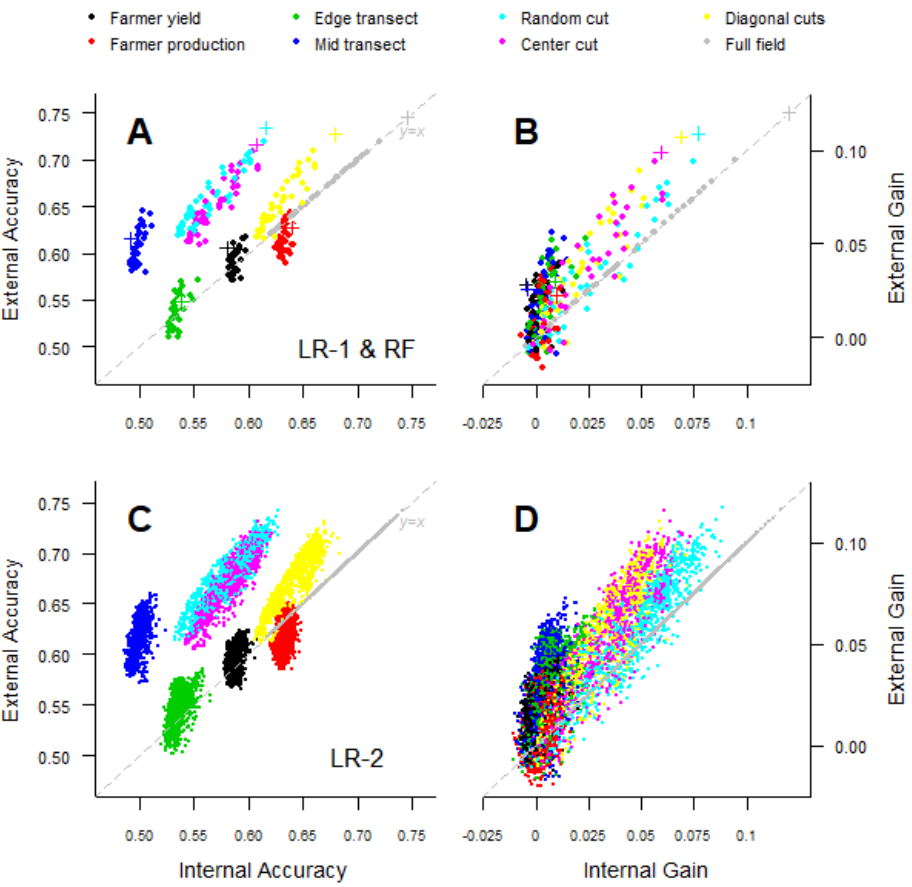
Figure 2. Internal and external accuracy and gain for models using data from 8 different field sampling methods to predicting maize yield with 1 or more of 45 Sentinel-2 reflectance-data-derived predictor variables. Single predictor variable (LR-1) and Random Forest (RF) (Panels ( A , B ); the Random Forest model is indicated with a + sign), and two-predictor-variable linear regression models (LR-2, Panels ( C , D